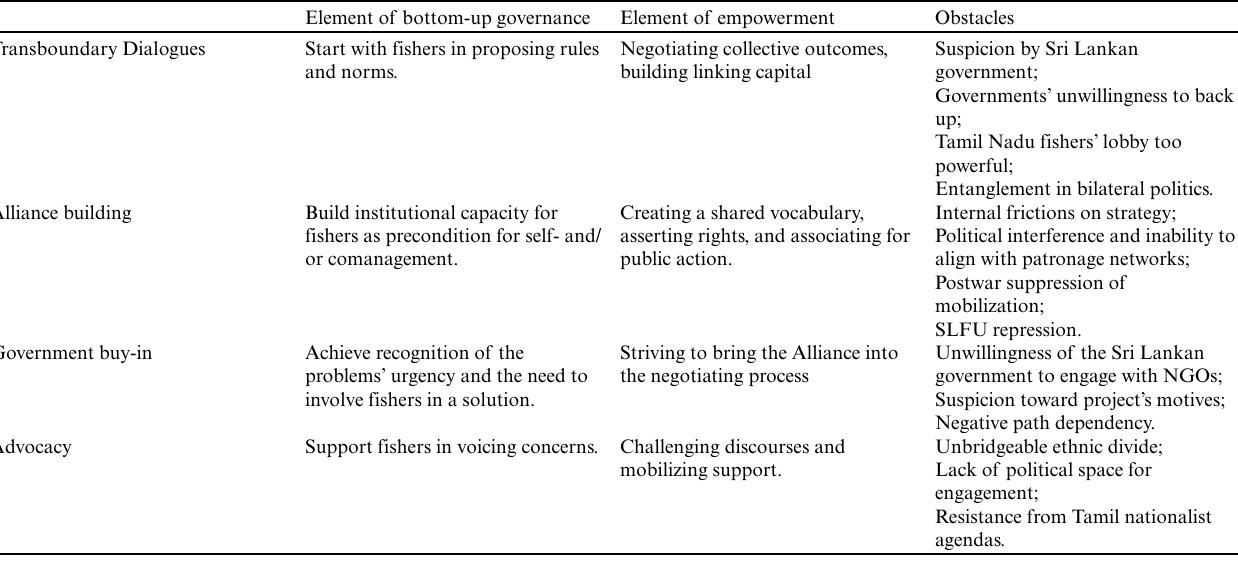
Table 3 . Project activities and obstacles